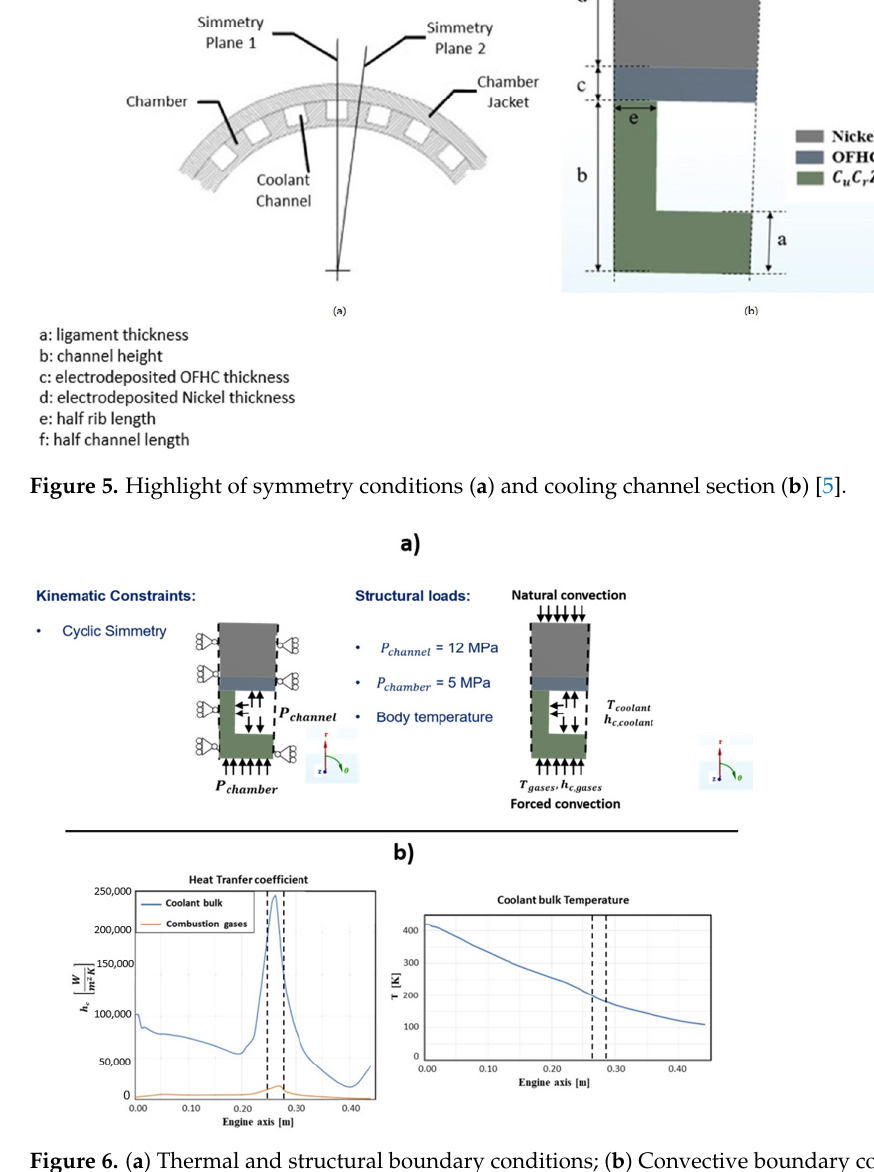
Figure 6. ( a ) Thermal and structural boundary conditions; ( b ) Convective boundary conditions [5,6].